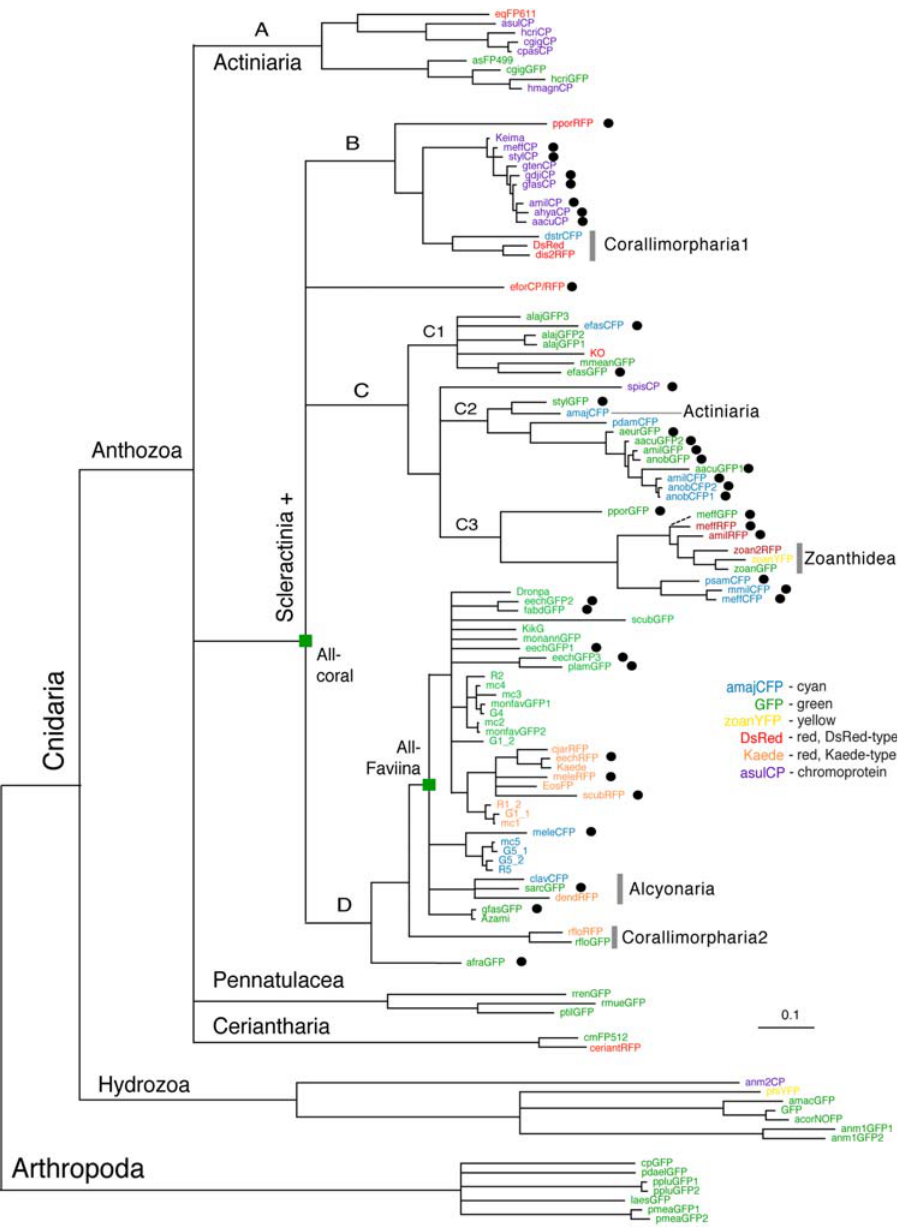
Figure 2. Bayesian phylogenetic tree of the cnidarian fluorescent proteins; Arthropoda FPs are shown as an outgroup. The edges with posterior probability less than 0.95 are collapsed. Black dots identify the proteins first described in this paper. Major clades and sub-clades are denoted, as well as the two reconstructed ancestral proteins (All-coral and All-Faviina). See legend for the color-coding of FP color classes. The position of meffGFP is tentative based on the short portion of its sequence that did not undergo gene conversion (see text for details). See Table S1 for the GenBank accession numbers corresponding to the protein names, and File S1 for the FASTA-formatted alignment of coding cDNA sequences.